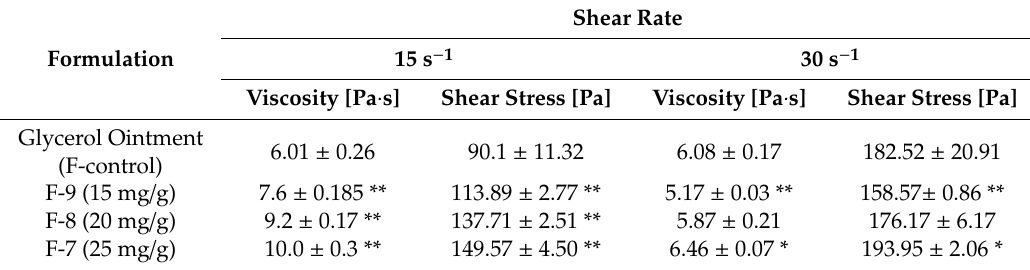
Table 5. Viscosity and shear stress values of hydrogels F-7–F-9 and F-control, * / ** statistically significant di ff erence ( p < 0.05 / p < 0.01) with respect to formulation F-control). Shear Rate 15 s − 1 30 s − 1 Formulation Viscosity [Pa · s] Shear Stress [Pa] Viscosity [Pa · s] Shear Stress [Pa] Glycerol Ointment 6.01 ± 0.26 90.1 ± (F-control)